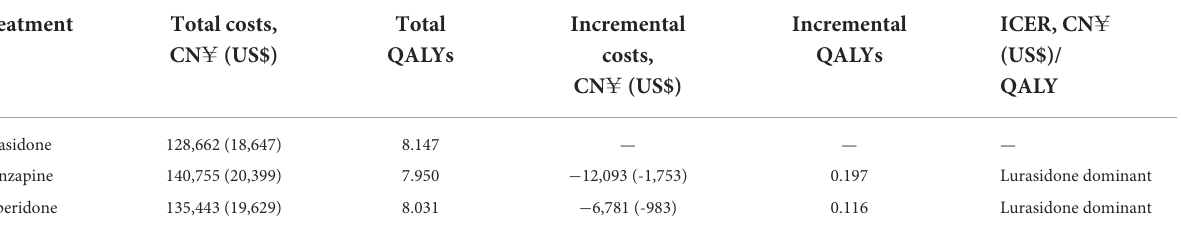
TABLE 4 Results of the base-case analysis.